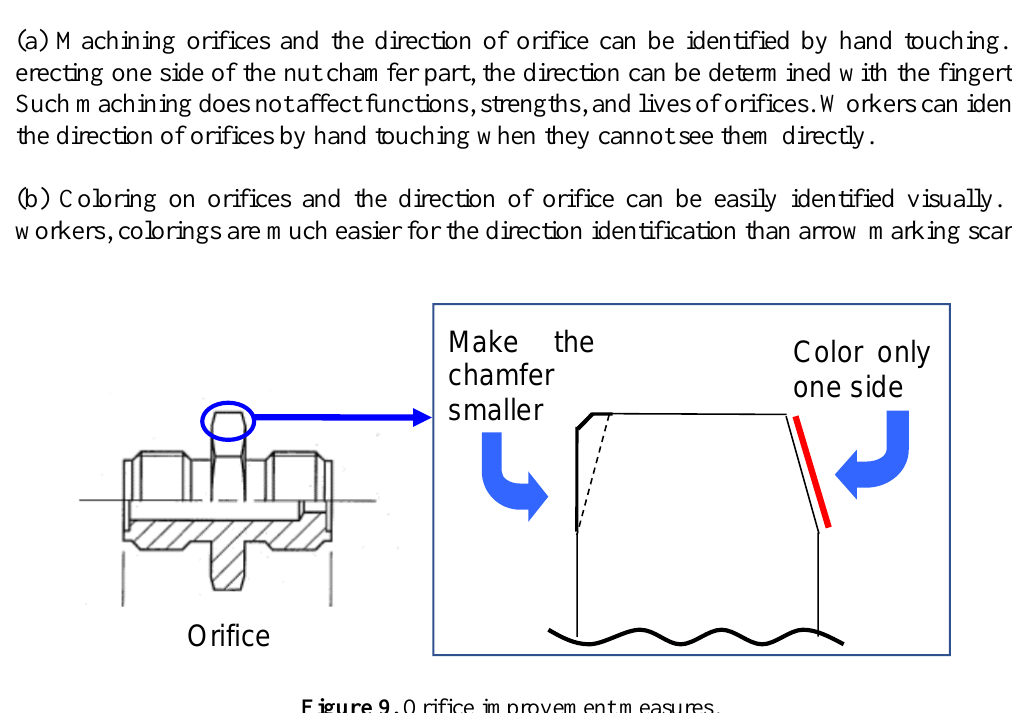
Figure 9. Orifice improvement